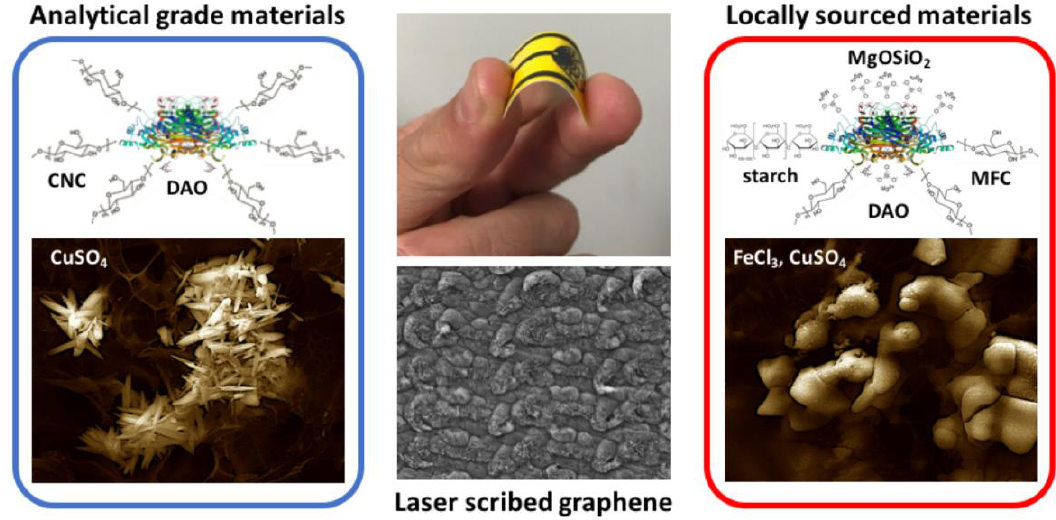
Figure 1. A low-cost, disposable nanobiosensor was developed for measuring biogenic amines in food using locally sourced materials, and was compared to sensors fabricated with analytical grade materials.